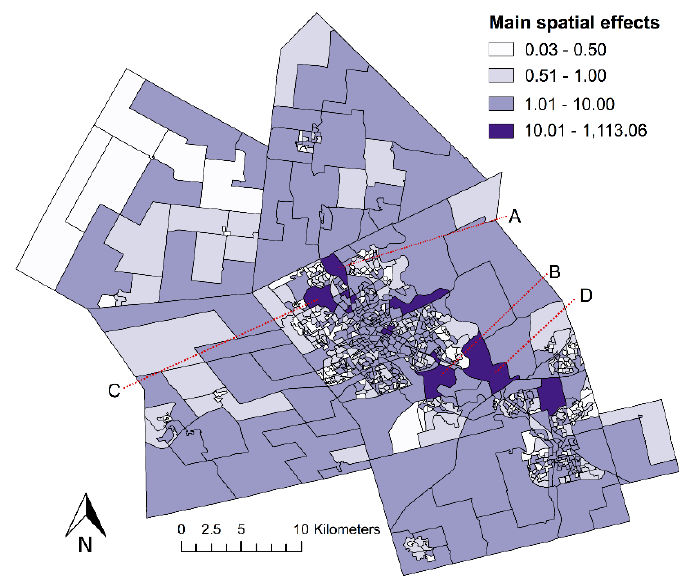
Figure 5. Main spatial effects (= exp(u i + s i )) of police calls-for-service.